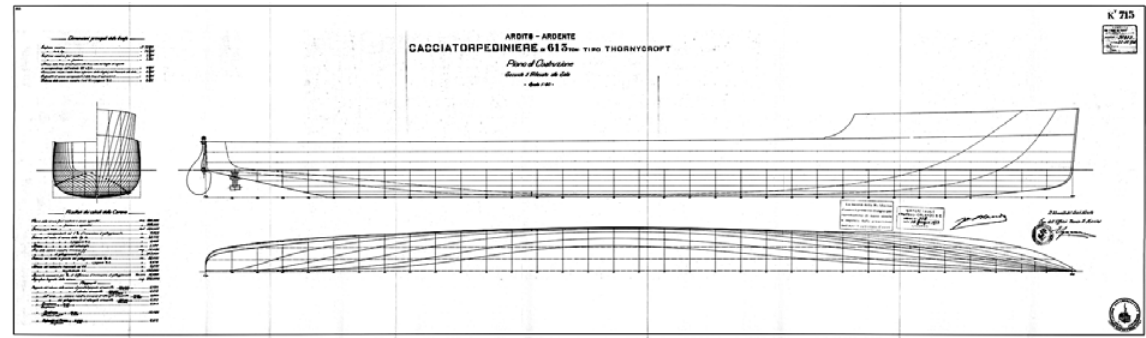
Figure 1: The original lines drawing of “Indomito” class warships.